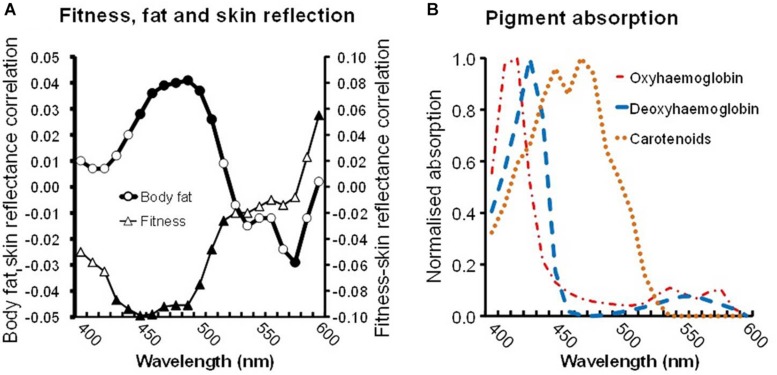
(A) Skin reflectance linked to fitness and to body fat. Triangles display the partial correlation between VO2 max and skin reflectance (controlling other variables, see text) at 10 nm intervals between 400 and 600 nm. Similarly, circles display the partial correlation between body fat and skin reflectance. Filled symbols denote significant correlations (P < 0.05). (B) Absorption spectra of skin pigments: oxyhemoglobin (red dashed dots), deoxyhemoglobin (blue dashes), and common carotenoids (average absorption of α, β-carotene and lycopene, orange dots). Note the fitness-reflectance and the fat-reflectance correlations are strongest for light of 450–500 nm, corresponding to the peak absorption of carotenoids.